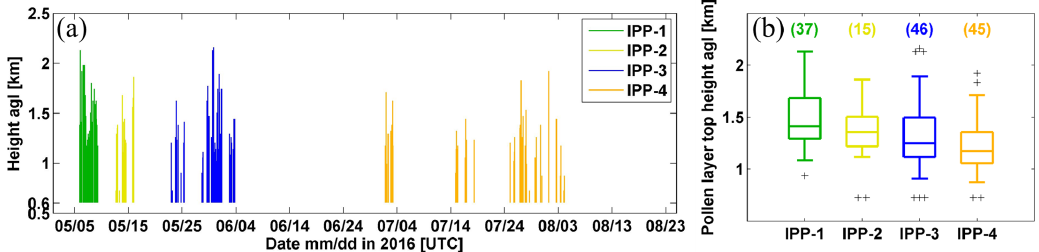
Figure 9. (a) Pollen layer definition for four intense pollination periods (IPPs). (b) Box plot of pollen layer top heights during each IPP. The number of available profiles is given. Colours are related to the IPPs.